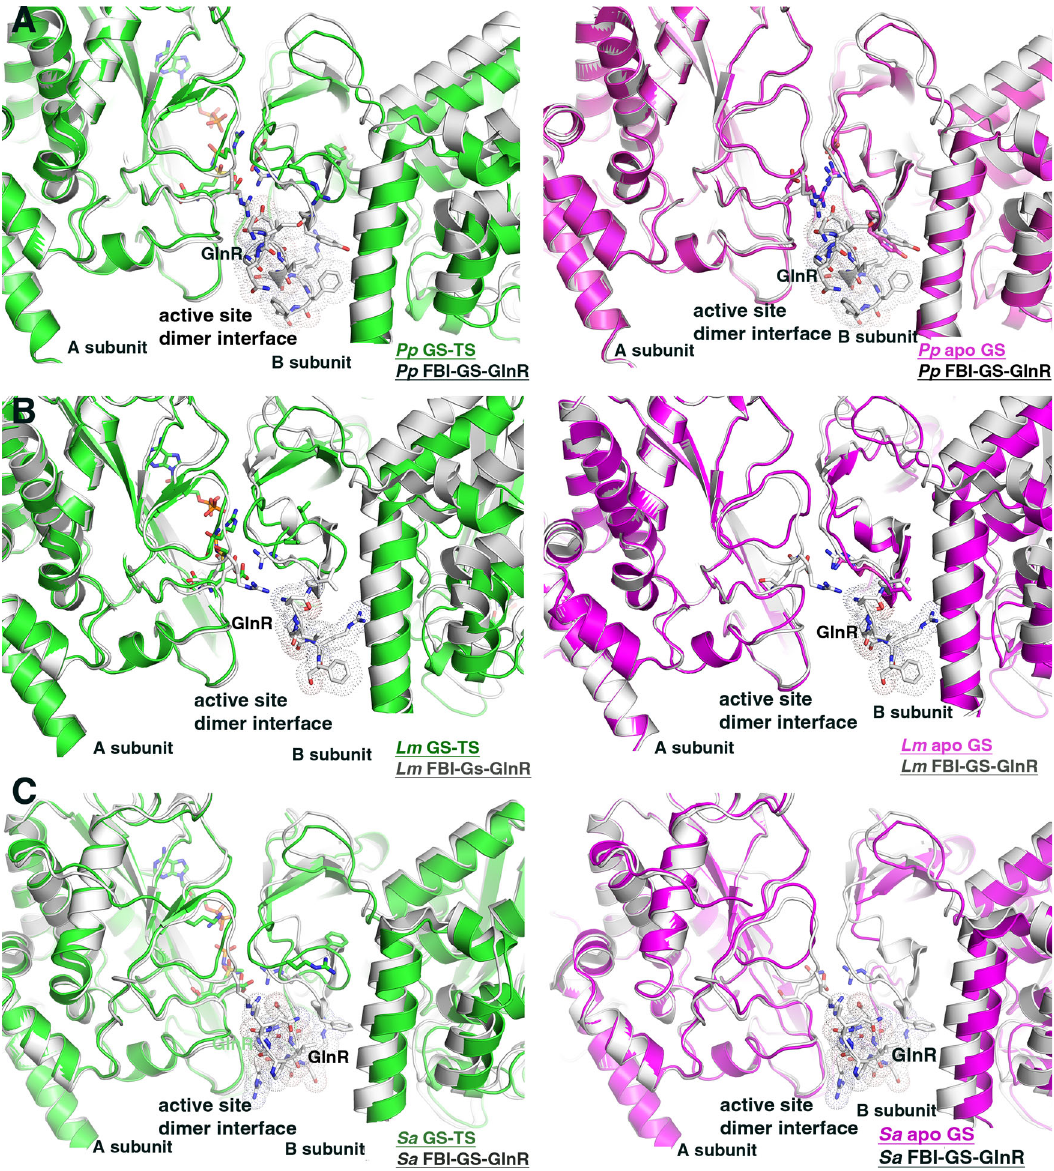
Fig. 6 A two state model for low G + C Gram-positive GS. Views comparing the active sites of the FBI-GS-GlnR structures to their corresponding TS (left) and apo (right) states for ( A ) Pp GS, ( B ) Lm GS, ( C ) Sa GS. The overlays reveal that the active sites are similar in the apo and GlnR-bound states but that the Met-Sox-P-ADP bound forms are strikingly different. In these fi gures the apo states are colored magenta, the GlnR-bound states are gray and the Met- Sox-P-ADP (TS) bound states are green. The GlnR C-tails are shown as sticks with dotted surfaces for